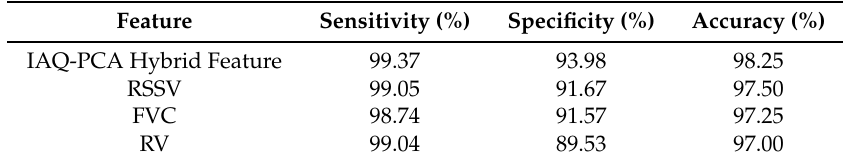
Table 9. Average PNN classification results comparison between the best features for the IAQ dataset.